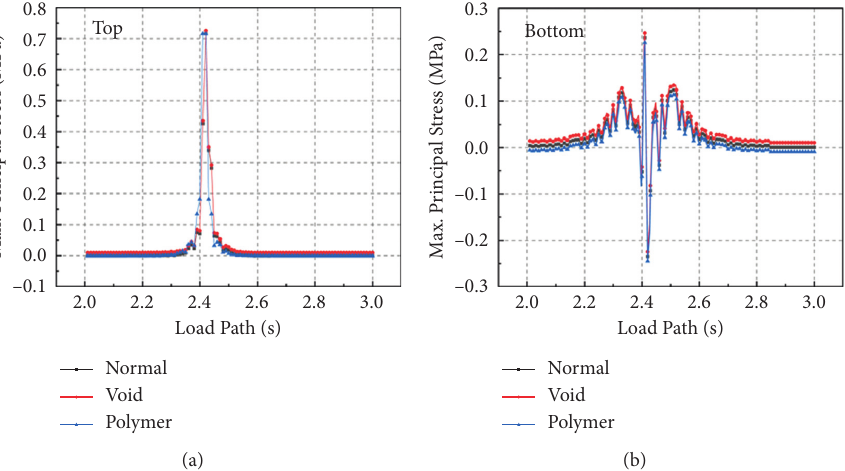
Figure 13: Time-history response curve of maximum principal stress in the middle of slab longitudinal edge: (a) at slab top and (b) at slab